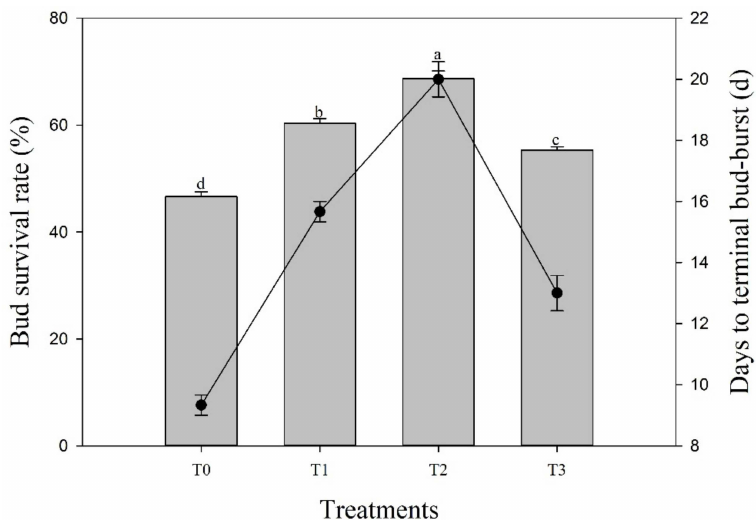
Figure 9. Bud survival rate (%) of Magnolia wufengensis under ethephon (ETH) treatments is shown in the bar chart. Days to terminal bud-burst of Magnolia wufengensis under ETH treatments is shown in the line